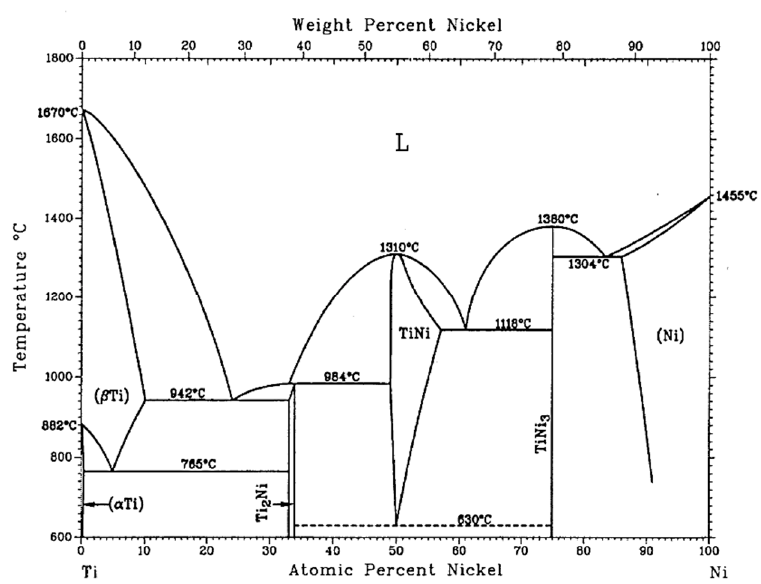
Figure 7. Influence of nickel content on martensite start temperature [75].